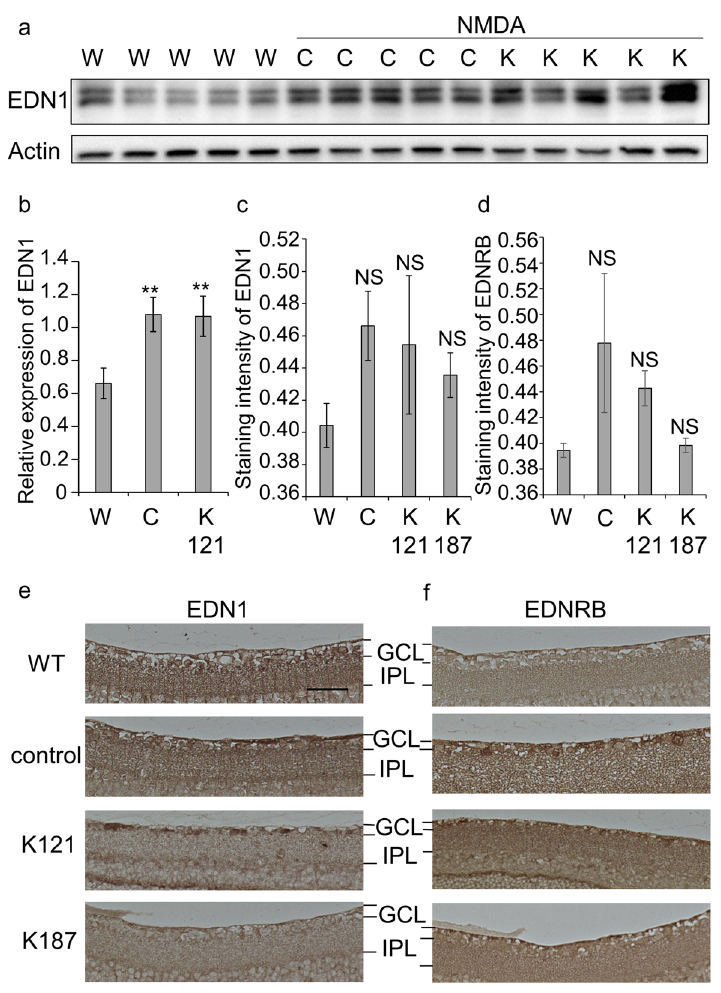
Figure 3. Protein expression of endothelin-1 (EDN1) and endothelin receptor type B (EDNRB) in retinal tissue. ( a ) The retina of non-treated wild-type (labeled ‘‘W’’), NMDA-injected (control, labeled ‘‘C’’), or NMDA- injected-KUS121-treated mice (labeled ‘‘K’’) was analyzed by western blotting using an anti-EDN1 antibody. Actin was used as a loading control. Complete scans of western blots are shown in Supplementary Fig. S2a. ( b ) Comparison of EDN1 expression shown as ratios to actin ( n = 5, for all treatments). ** p < 0.01, vs. W, Tukey’s HSD. ( c – f ) Vertical sections of non-treated wild-type, NMDA-injected, NMDA-injected-KUS121-treated and NMDA-injected-KUS187-treated mice retinae were stained with an anti-EDN1 antibody or anti-EDNRB antibody. ( c , d ) Staining intensities of RGC layers with anti-EDN1 ( c ) or anti-EDNRB ( d ) antibody. The staining intensity of the RGC layer at distances of 400–800 μm from the optic nerve head was analyzed using BZ II Analyzer software. W: non-treated wild-type, C: NMDA-injected, K121: NMDA-injected-KUS121-treated, K187: NMDA-injected-KUS187-treated. ( n = 3, for C and K121, n = 2, for W and K187) NS no significant difference compared with W, Tukey’s HSD. ( e,f ) Vertical sections of non-treated wild-type (WT), NMDA- injected (control), NMDA-injected-KUS121-treated (K121) and NMDA-injected-KUS187-treated mice (K187) retinae. The black bar represents 100 µm. GCL ganglion cell layer, IPL inner plexiform